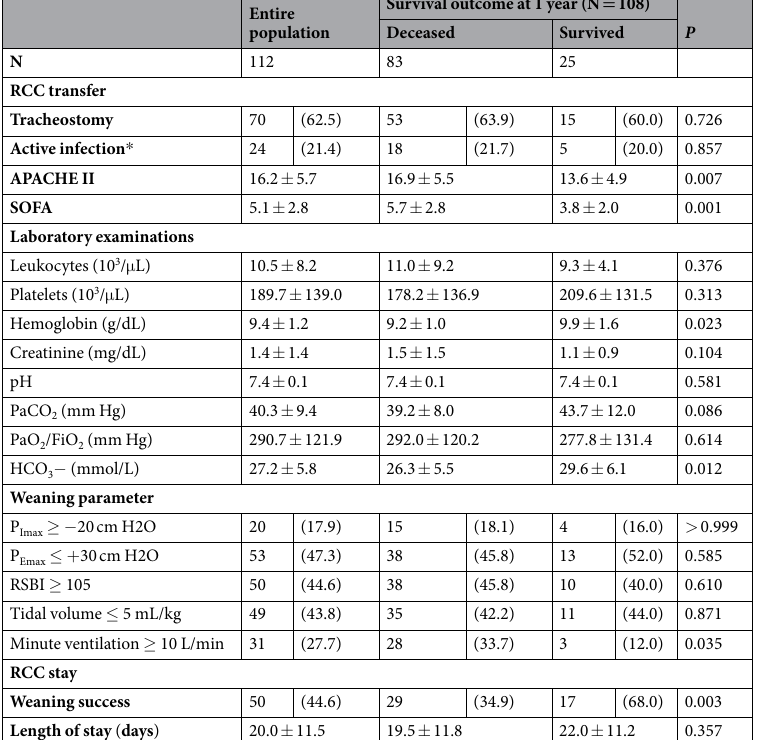
Table 3. Clinical characteristics during respiratory care center hospitalization. Data are presented as mean ± standard deviation or number (%). APACHE II, Acute Physiology and Chronic Health Evaluation score; FiO 2 , fraction of inspiratory oxygen; PaCO 2 , arterial partial pressure of carbon dioxide; PaO 2 , arterial partial pressure of oxygen; P